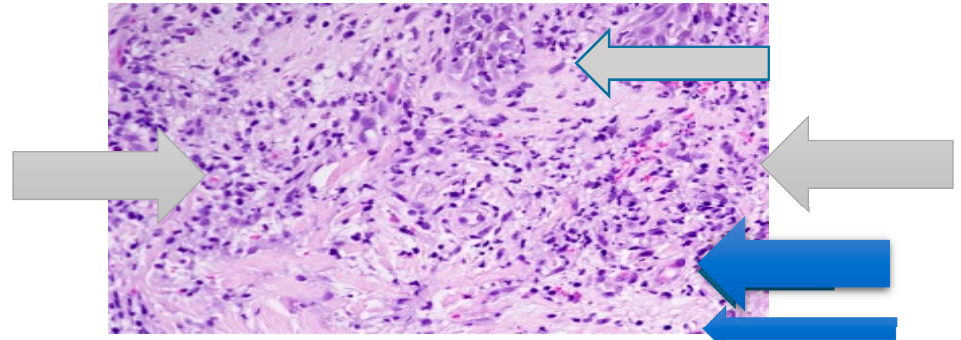
Figure 2. Papillary dermal edema, swollen endothelial cells (blue arrow), and diffuse infiltrate of neutrophils (grey arrow). No evidence of vasculitis (hematoxylin and eosin stain, ×100 magnification).